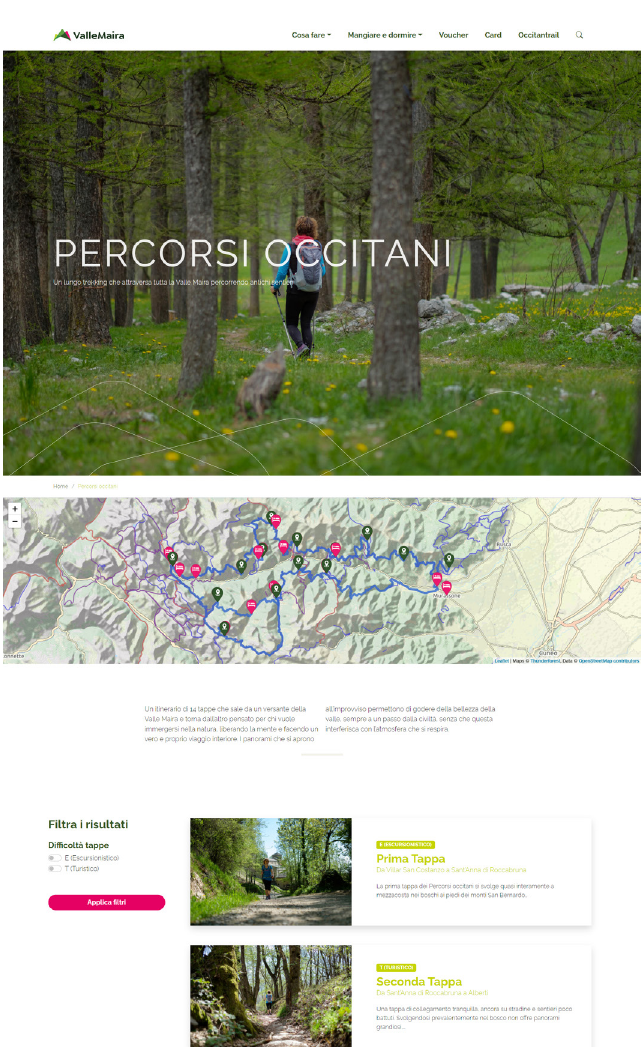
Fig. 3 The Percorsi Occitani web platform